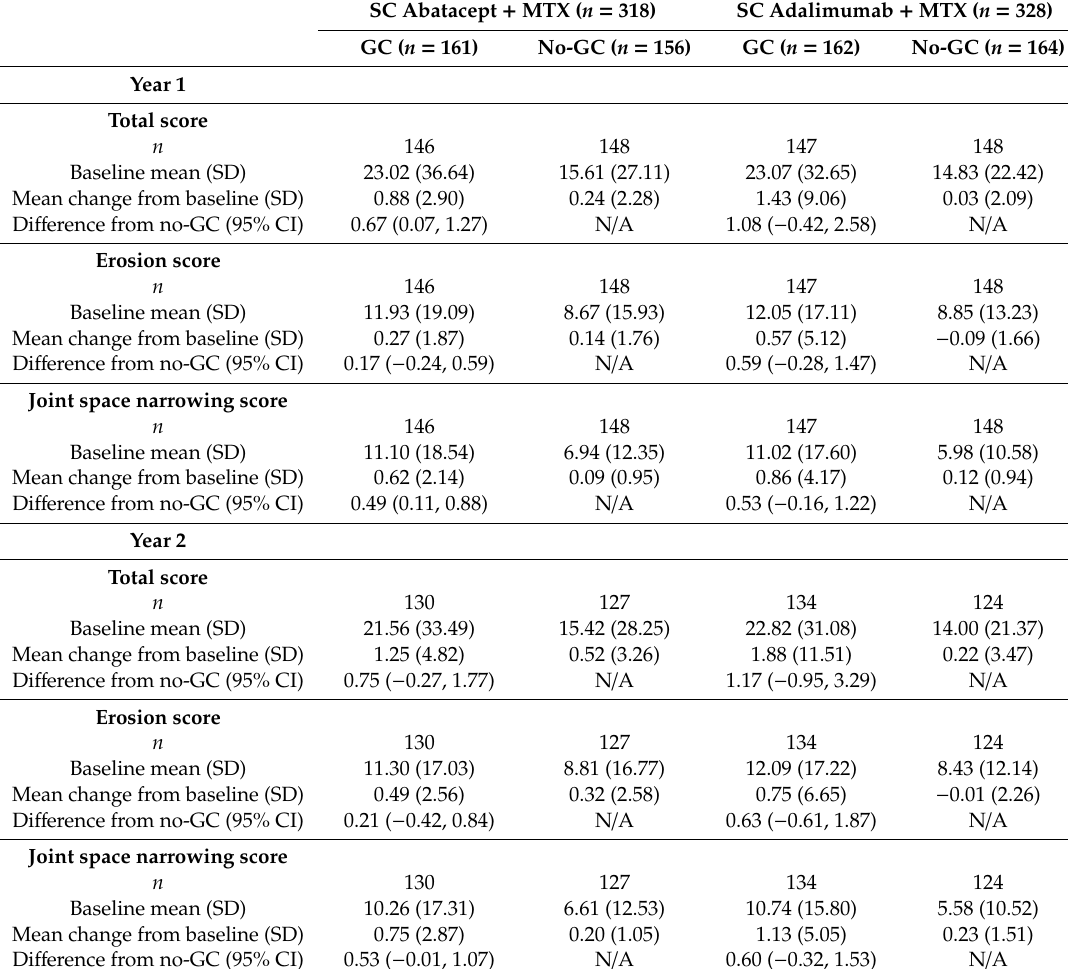
Table 2. Change in modified total Sharp score from baseline at Years 1 and 2 a